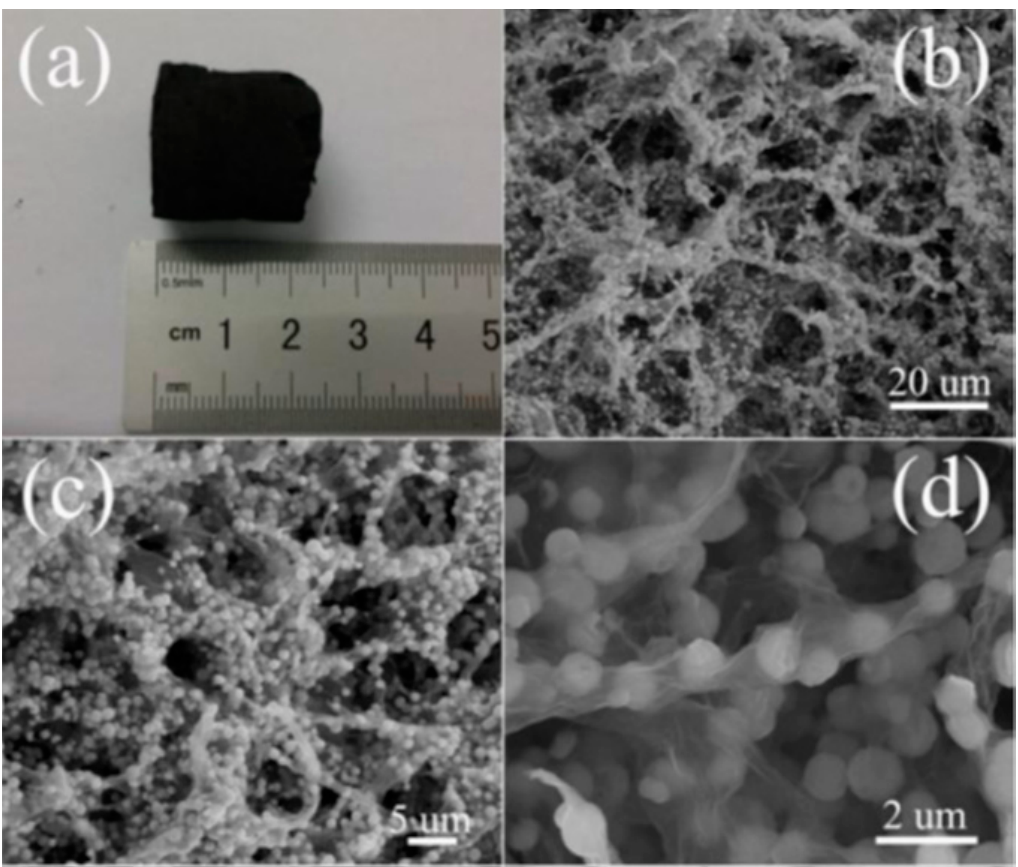
Figure 9. Morphology of 3D rGO aerogel/ZnO spheres composite. ( a ) A photograph of composite. ( b–d ) SEM images with different magnifications of rGO aerogel/ZnO spheres composite. Reproduced with permission from [43], © 2015